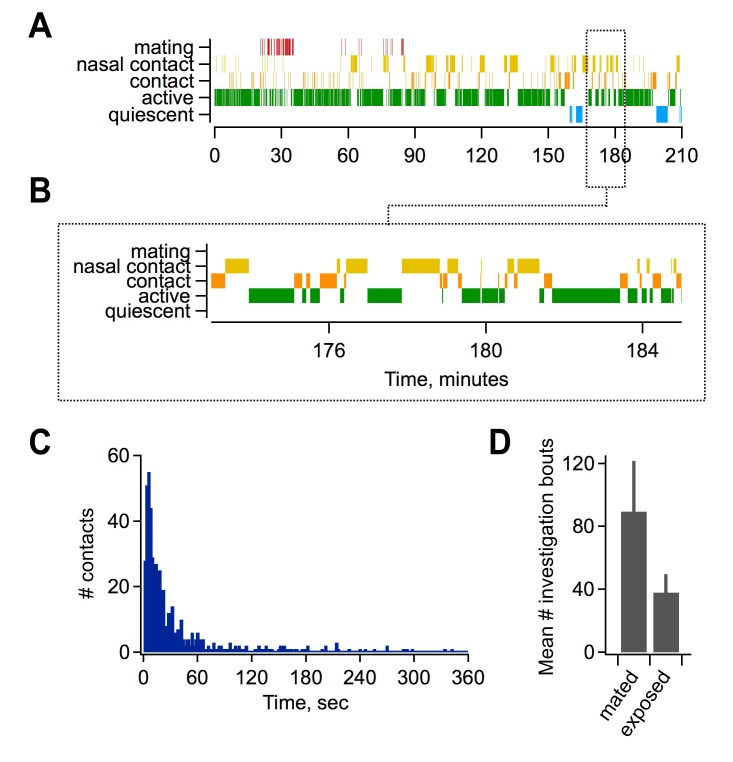
Mating and sensory interactions during pairing.(A) Video analysis of characteristic post-mating behavior between females and males. Top, mating typically occurred early during the pairing period (red), followed by extensive and repetitive behavioral encounters including direct nasal contact required for vomeronasal activation (yellow). Bottom, expanded view of approximately 10 min of female-male interactions. (B) Distribution of intervals between investigatory bouts in the mated group (mean, 62.1 ± 7.99 s; median, 15.9 s; n = 554 bouts in 7 animals). (C) Investigatory behavior is elevated in mated relative to sensory-exposed groups (mean bouts per female, 89.5 ± 32.1 vs. 38 ± 11.6 respectively; n = 7 animals per group).